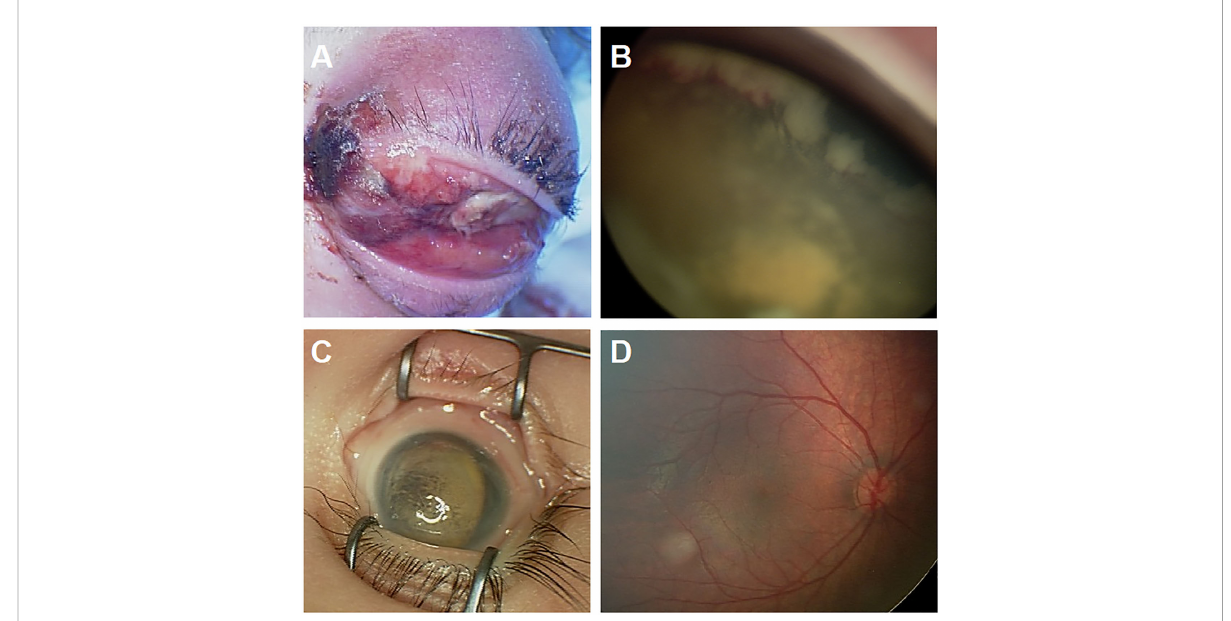
FIGURE 1 (A) Represents one of the refugees who came after 6 months of having leukocoria as a sign of ocular disease in the left eye and did not seek care until the patient developed extraocular disease extension. She passed away with bone marrow metastasis. (B, C) This patient is a refugee who presented with bilateral advanced intraocular Retinoblastoma. The right eye (B) showed extensive tumor that is extending to the ciliary body, and the left eye (C) had phthisis bulbi due to advanced disease, and unfortunately ended with bilateral enucleation. (D) This child was diagnosed by screening and had right group A tumor.